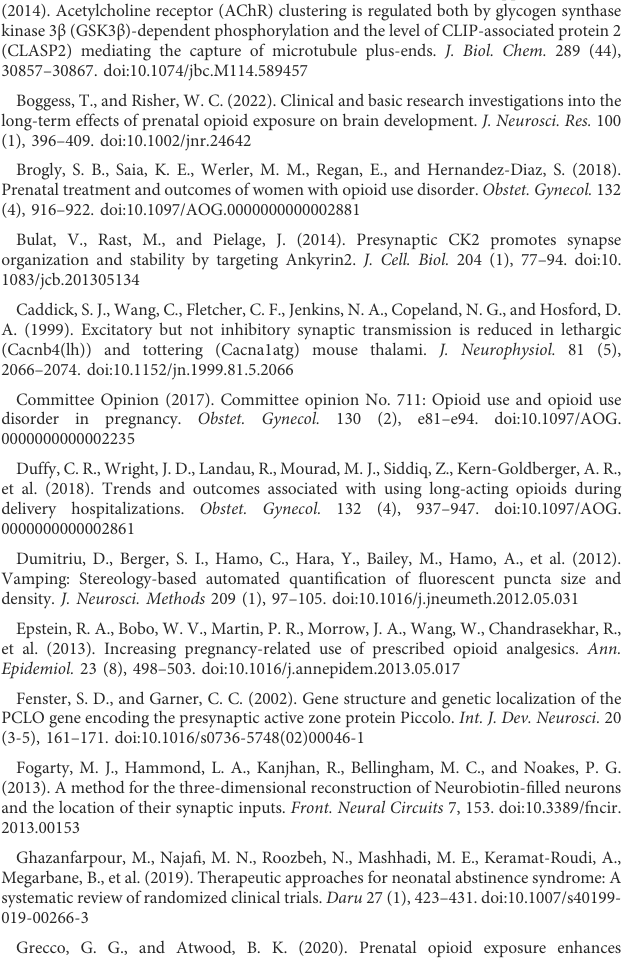
SUPPLEMENTARY FIGURE S1 Differential protein and phosphopeptide expression in the primary motor cortex (M1) of prenatal methadone exposed offspring. Clusterplots of differentially abundant proteins (A) and phosphopeptides (B) with example GeneIDs. ( n = 8 (4M:4F) PME, 8 PSE